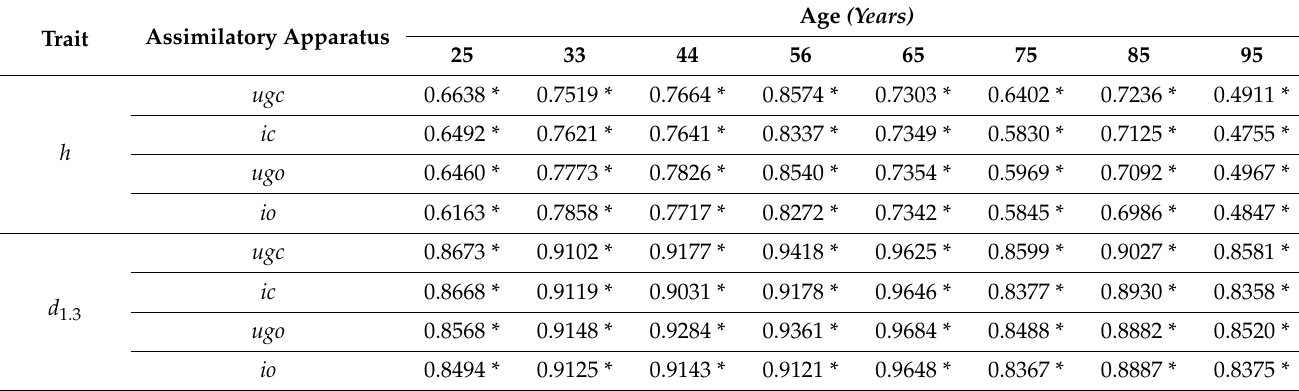
Table 6. Values of linear correlation coefficients r between the size of the assimilatory apparatus ( ugc , ic , ugo , io ) and dendrometric traits ( h , d 1.3 ) depending on the age of stands.